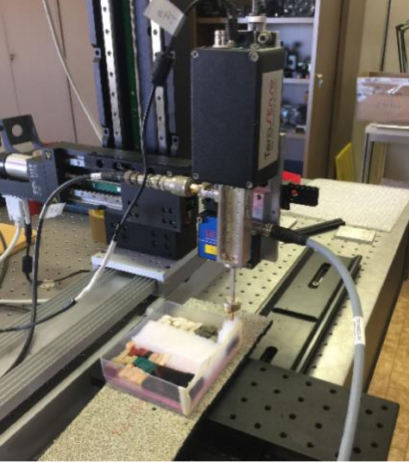
Figure 22. Setup for horizontal measurements with the mosaic mockup described in Figure 21a.